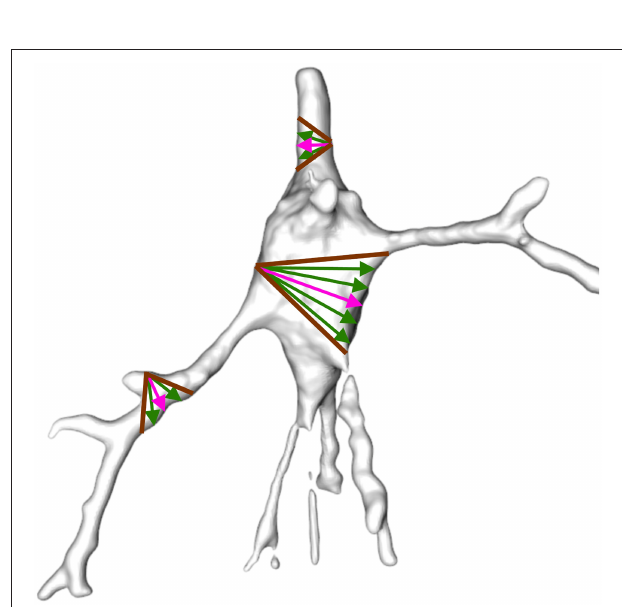
FIGURE 5 | Example of shape diameter function. A cone (brown) is centered on the inward-normal of each vertex (pink arrow). Several rays (green) are sampled inside the cone such that the sum of the length of the rays from the vertex to their intersection with the mesh surface on the opposite side of the mesh approximates vicinity volume. The rays sampled inside the soma are longer than the rays sampled inside the dendrites and the volume of the vertices in the vicinity of the soma is therefore greater.